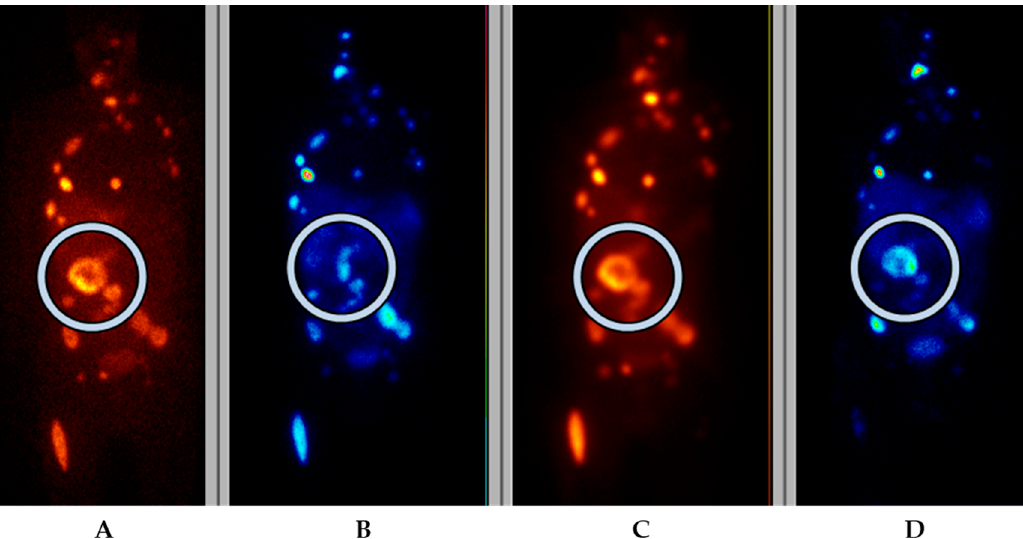
Figure 3. Frontal planar scintigraphy images in patient No. 4, in whom the primary PCC had higher uptake on 123 I-MIBG scintigraphy ( A ) than on somatostatin receptor scintigraphy (OctreoScan™) ( B ). After one cycle of 131 I-MIBG ( C scintigraphy during therapy) an upregulation of somatostatin receptors was noted and further therapy was given with 177 Lu-DOTA-octreotate ( D scintigraphy during therapy).